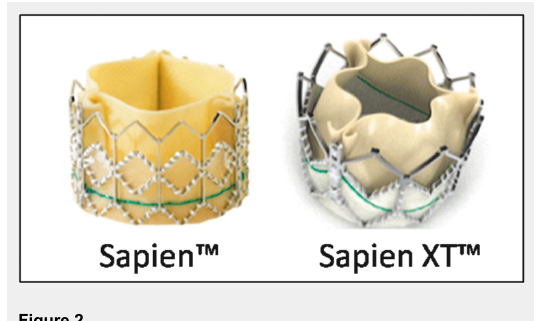
The Sapien TM THV (left) and the new Sapien XT TM generation (right) by Edwards Lifesciences, Irvine, CA, for antegrade and retrograde